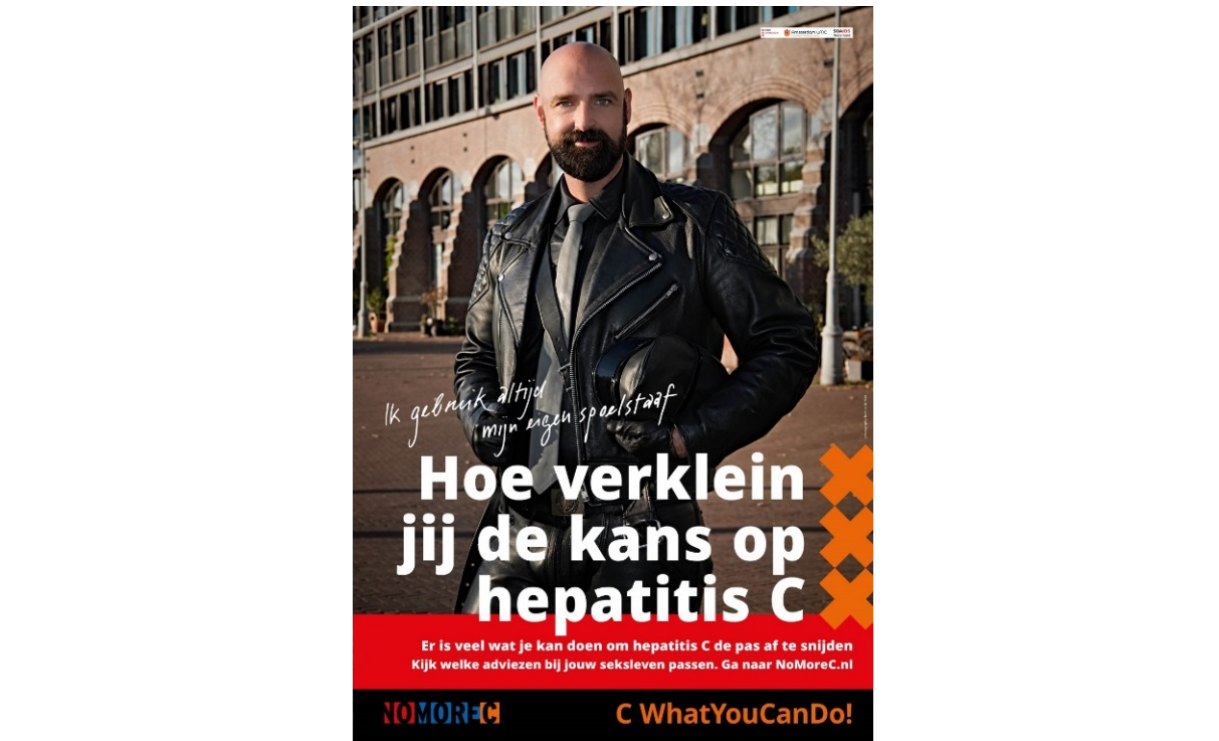
Figure 7. Promotional poster with the text: How do you reduce your hepatitis C Risk “I always use my own anal douche.” The model is a key figure from the target